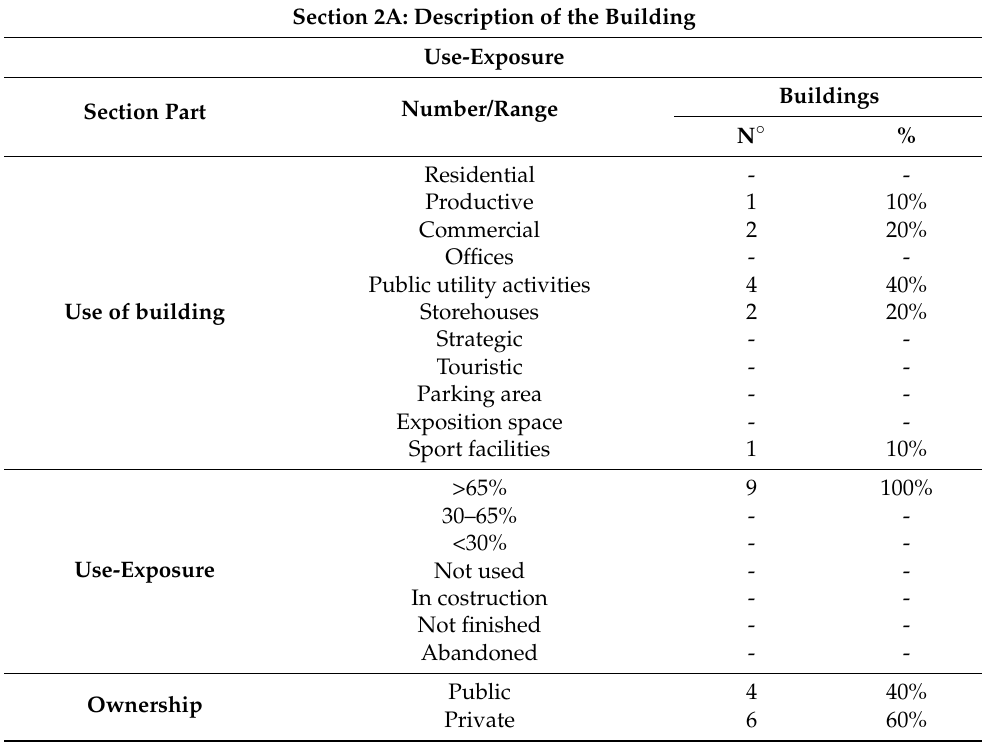
Table 10. Section 2 CARTIS-Building. Case studies characterization: Use—Synoptic panel.